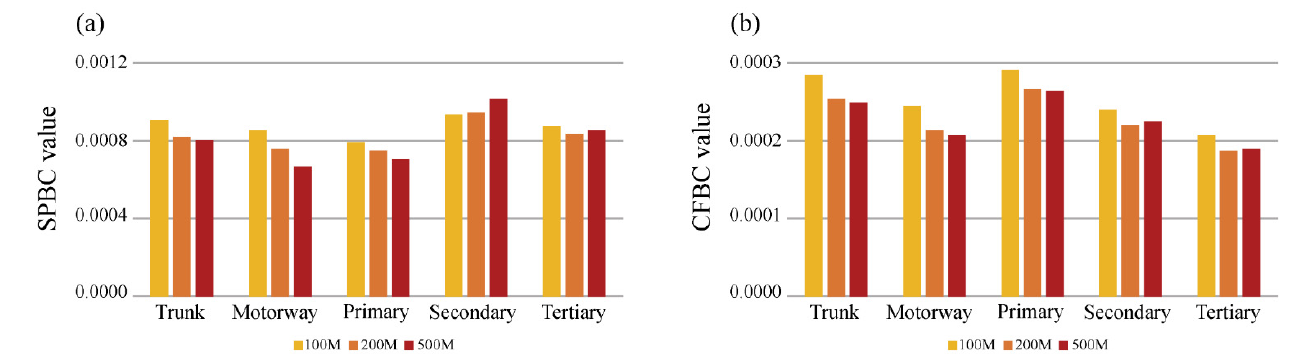
Figure 4. The comparison of mean ( a ) SPBC and ( b ) CFBC values according to roadway types and PM 2.5 dispersion models.